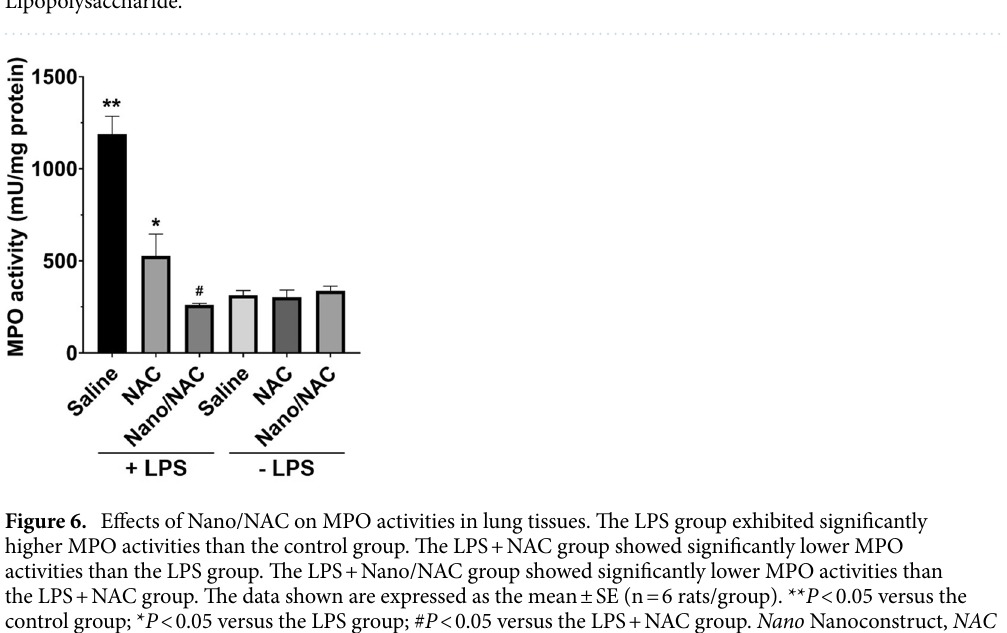
Figure 5. Effects of Nano/NAC on histological alterations in lung tissues. The lung tissues from the LPS group demonstrated significant pathological changes, including alveolar and interstitial neutrophil infiltration (arrow head in magnified box), alveolar and interstitial hemorrhage, alveolar septal thickening (arrow in magnified box), and proteinaceous debris in the alveoli, when compared with the control group. These pathological changes in the LPS group were significantly attenuated by co-treatment with NAC or Nano/NAC, with a greater significant difference observed in the Nano/NAC group (hematoxylin and eosin staining, × 200). The lung- injury score, an objective measure of the degree of ALI, was significantly higher in the LPS group than in the control group. The lung-injury score was significantly decreased by co-treatment with NAC or Nano/NAC, with a greater significant difference observed in the Nano/NAC group. No significant difference was found between the control and NAC or Nano/NAC groups in terms of the lung-injury scores. The data shown are expressed as the mean ± SE (n = 6 rats/group). ** P < 0.05 versus the control group; * P < 0.05 versus the LPS group; # P < 0.05 versus the LPS + NAC group. Nano Nanoconstruct, NAC N-acetylcysteine, ALI Acute lung injury, LPS